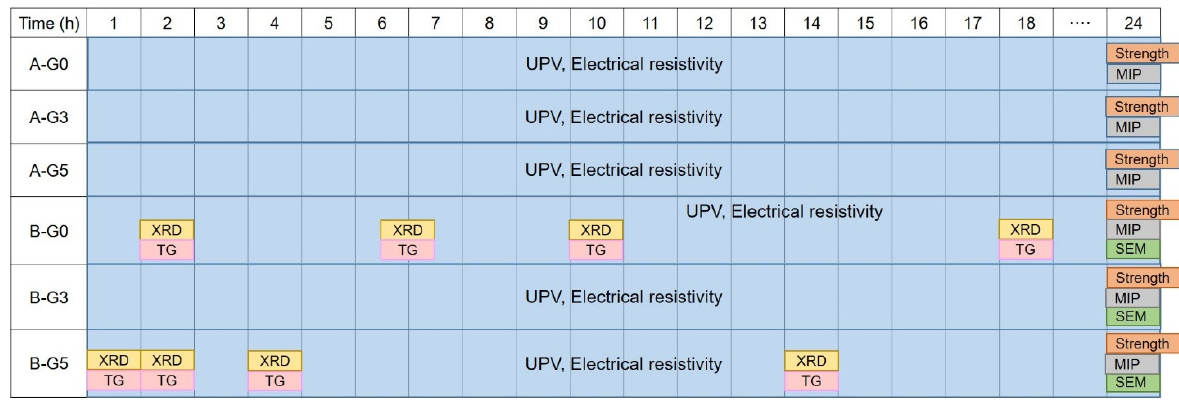
Figure 5. Selection and description of test cases according to a test